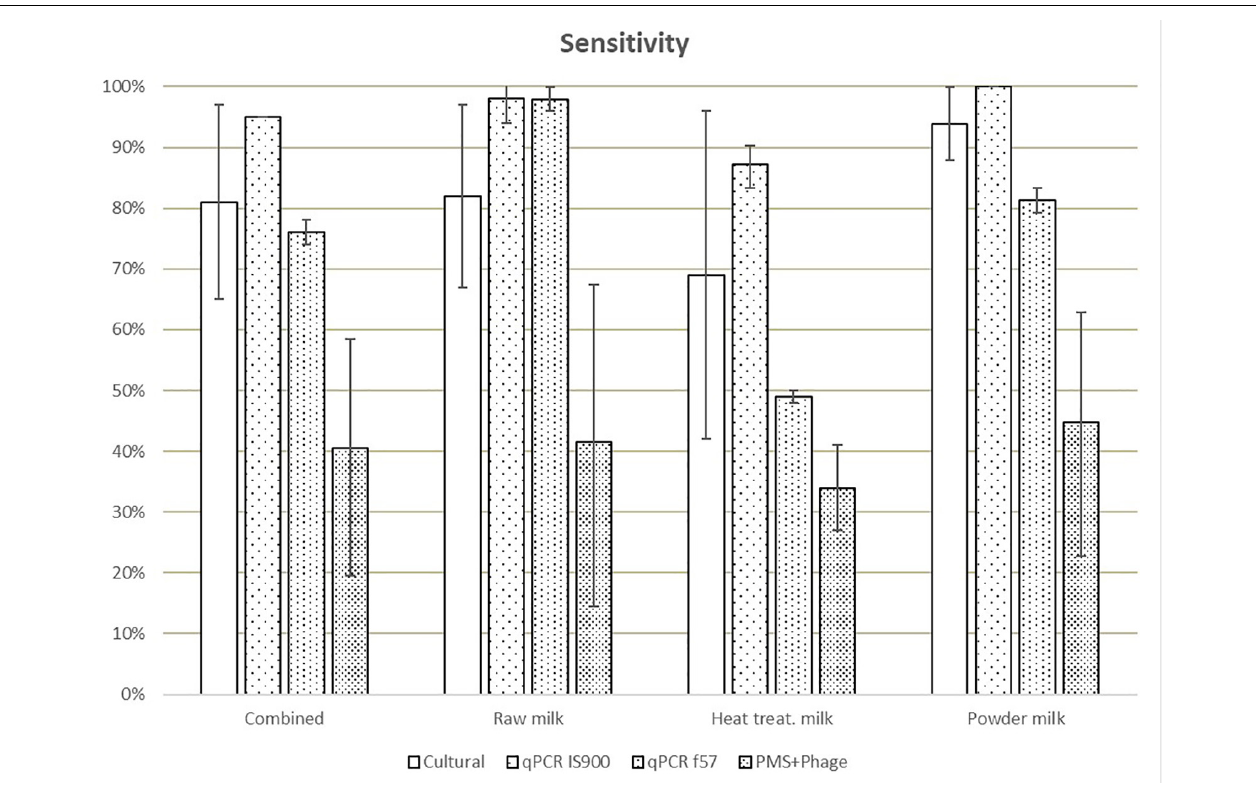
FIGURE 1 | Means of the sensitivity values obtained in each laboratory for all dairy categories and methods. Error bars show the values obtained by laboratory A and laboratory